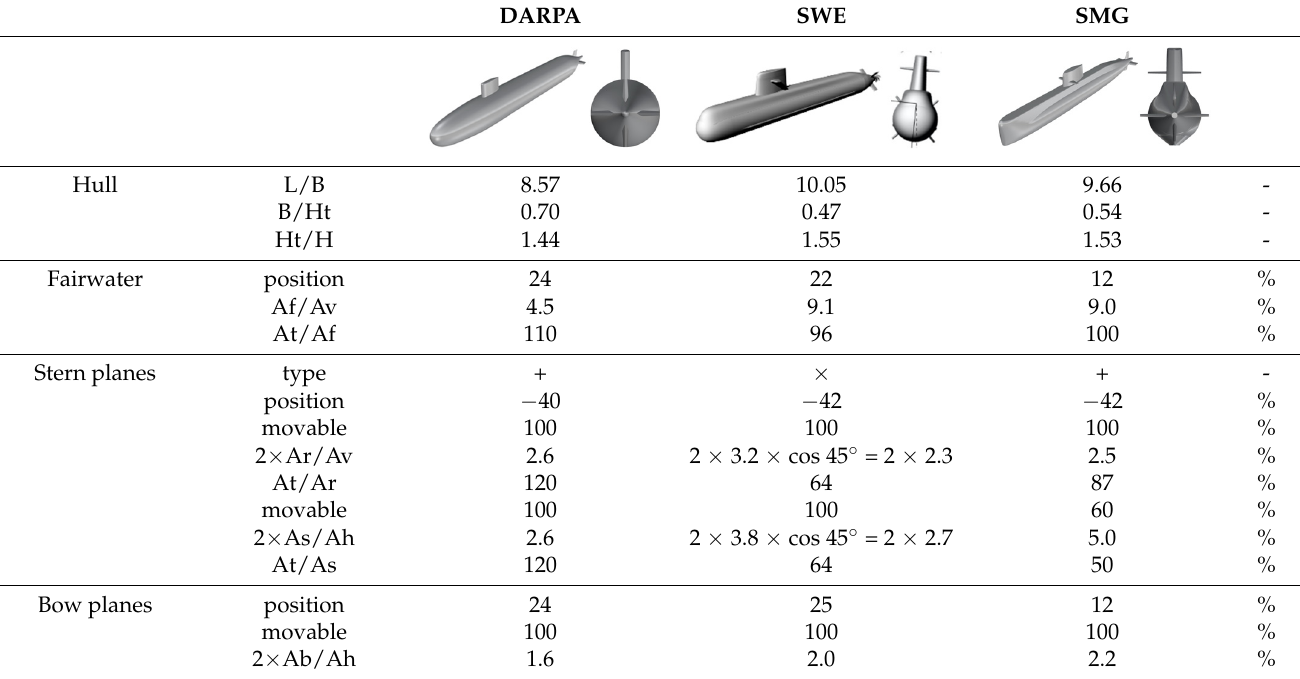
Table 1. Submarines—case studies. DARPA